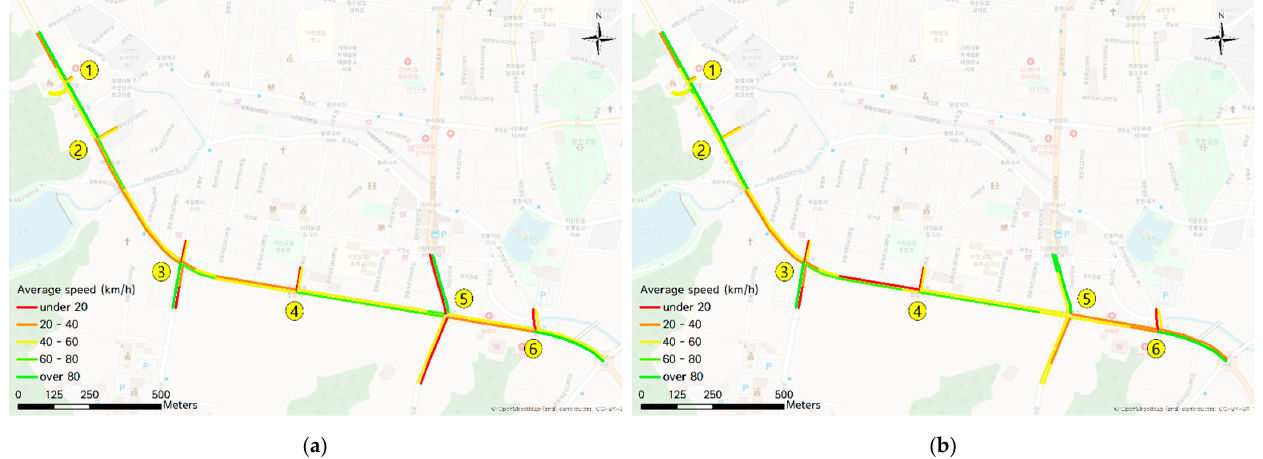
Figure 10. Traffic condition: ( a ) Comparison model; ( b ) Proposed model.